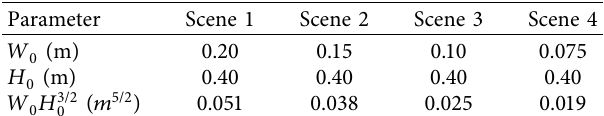
Table 2: Values of ventilation factors according to geometric configurations.